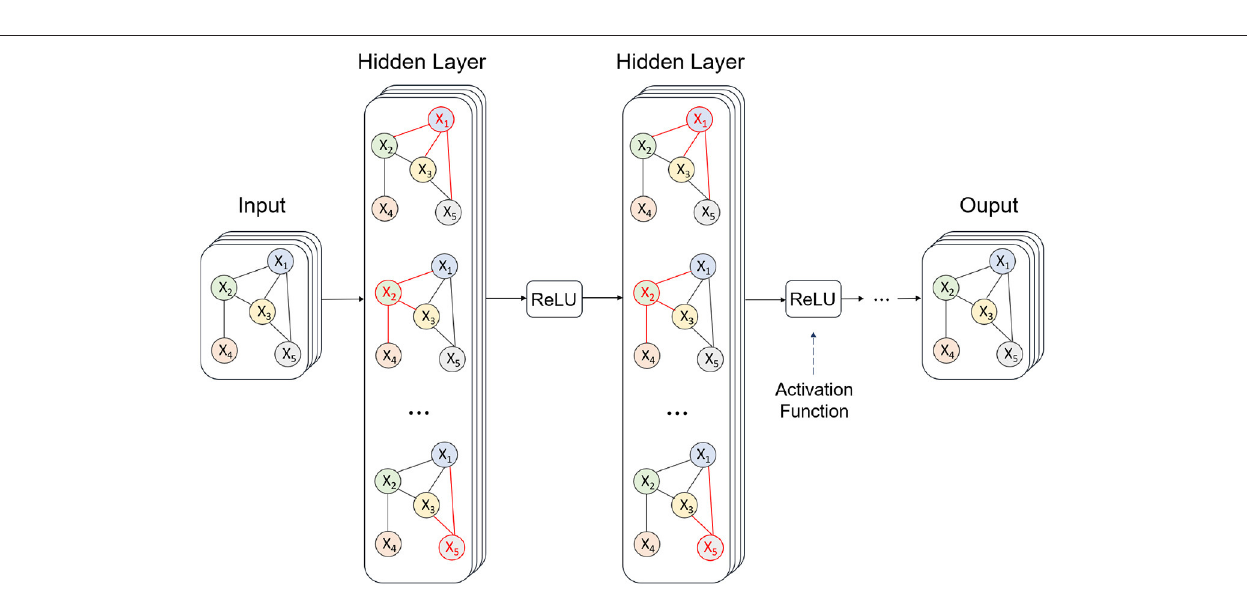
FIGURE 2 | Workflow of the graph convolutional network employed for prediction.